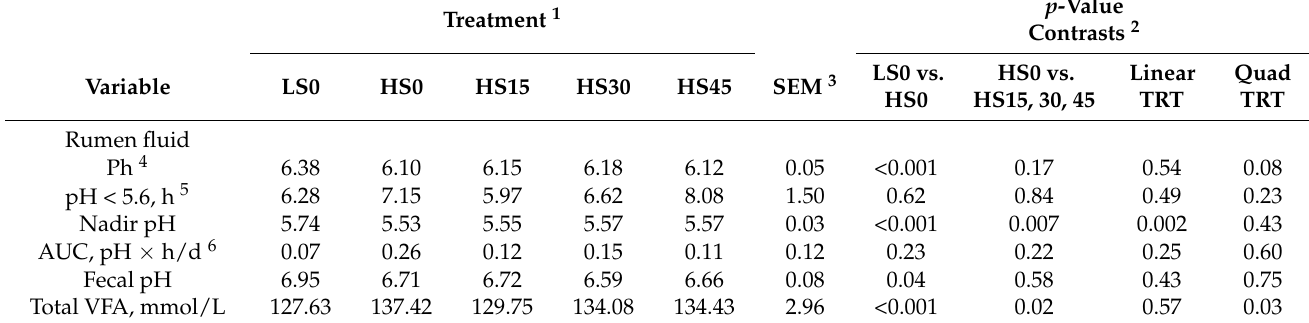
Table 5. Least squares means and associated SEM of nitrogen excretion and apparent digestibility in a low-starch diet without autolyzed yeast products (LS0), high-starch diet without autolyzed yeast products (HS0), HS with 15 g (HS15), 30 g (HS30), and 45 g (HS45) of autolyzed yeast during the experimental period.